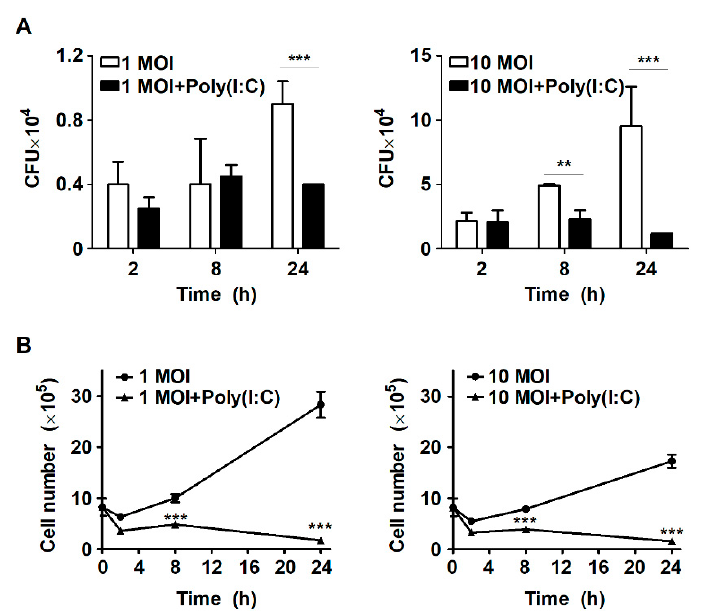
Figure 1. Poly(I:C) controls intracellular bacterial growth in S . Typhimurium-infected cells. ( A ) RAW264.7 cells were infected with S . Typhimurium at an MOI of 1 or 10 and then treated with poly(I:C) (10 µ g/mL) for the indicated durations. Intracellular growth of S . Typhimurium was assessed by CFU assay. ( B ) The number of RAW264.7 cells was determined using a trypan blue exclusion assay. The data are presented as the mean ± SD ( n = 3), and were analyzed via two-way ANOVA followed by Bonferroni’s post hoc test; ** p < 0.01, *** p <